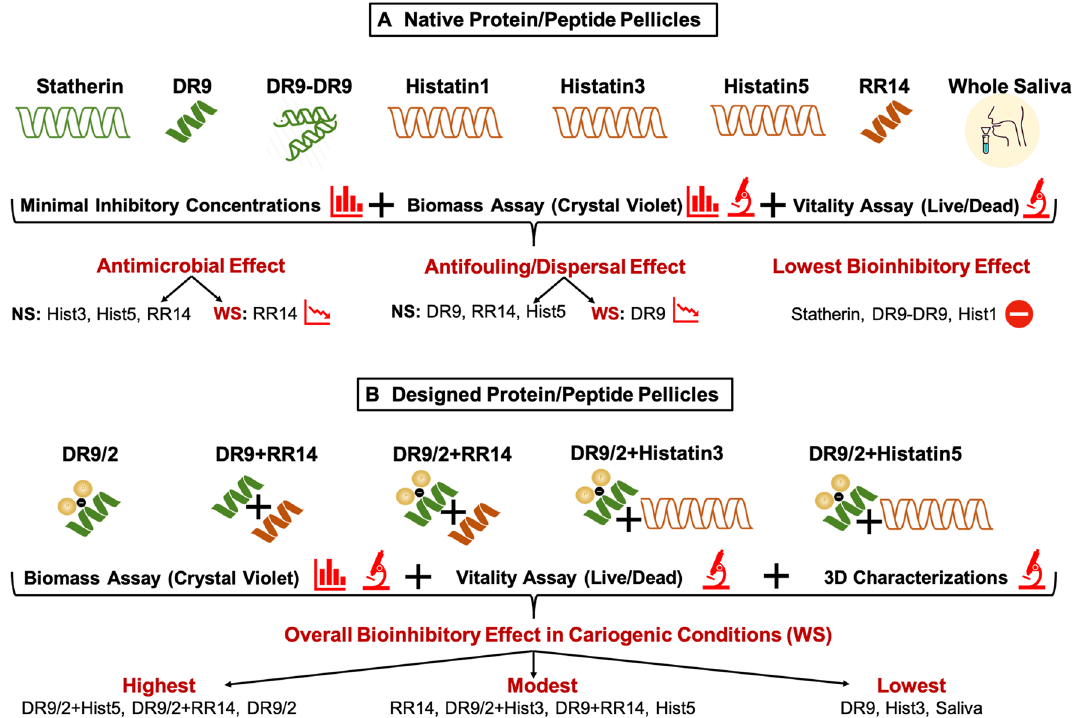
Figure 1. Schematic diagram depicting the workflow for studying the bioinhibitory effects of saliva-derived proteinaceous pellicles on the S. mutans U159 biofilms in normal and cariogenic conditions. ( A ) The native pellicles comprising the highly abundant proteins/peptides identified in the in-vivo human acquired enamel pellicles except for (DR9-DR9). The green color refers to the statherin protein family and its functional domain fragment (DR9) or the duplicated construct (DR9-DR9). The brown color refers to the histatins family and its functional domain fragment (RR14). All these candidates were tested for their bioinhibitory properties using qualitative (denoted by the microscope symbol) and quantitative (denoted by the bar graph symbol) assessment methods versus the human pooled whole saliva as a control in normal and cariogenic conditions. (No Sucrose “NS”) represents the normal conditions where biofilms were grown in brain heart infusion (BHI) medium without sucrose supplementation. (With Sucrose “WS”) represents the cariogenic conditions where biofilms were grown in BHI medium with 1% sucrose supplementation. Sucrose supplementation was included to assess the impact of disaccharides-mediated bacterial massive growth and associated high acidity on the behavior of tested candidates. The efficacy of all tested proteins/peptides/fragments was deteriorated in the challenging cariogenic condition; however, the significantly declined ones were specifically symbolized and the candidates showed the lowest bioinhibitory effects were excluded from further experimentation. ( B ) The novel pellicles were designed by either unphosphorylation of the DR9 functional domain, by removing the covalently linked phosphates at the 2 nd and 3 rd serine residues (DR9/2), or by hybridization of complementary-acting functional domains derived from the two different protein families. Our bioengineering strategies aimed to increase the biofilm dispersion and/or attain multifunctional synergistic effect in the challenging cariogenic (WS) conditions. All novel protein/peptide constructs were tested and characterized for their bioinhibitory properties in comparison to the native protein/peptide candidates in the sucrose-supplemented cariogenic condition. The overall bioinhibitory effect (the antimicrobial and/or the antifouling/biofilm-dispersal properties) were concluded in descending order in 3 categories (highest, modest, and lowest). Hist1, Histatin1; Hist3, Histatin3; Hist5,